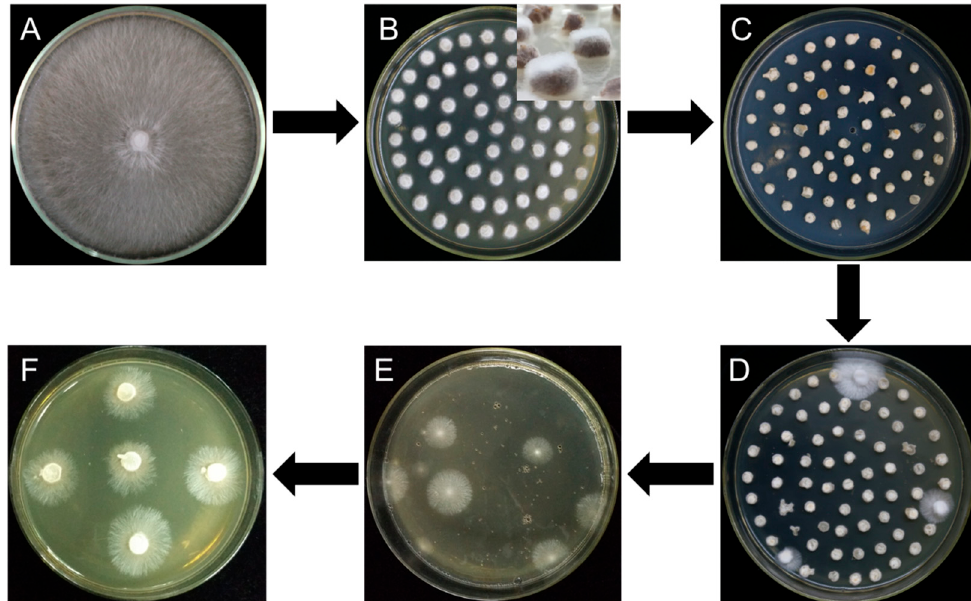
Figure 2. Flow diagram for Agrobacterium tumefaciens -mediated transformation of L. edodes. (A) Strain activation; (B) mycelial plugs overgrown with freshly germinated hyphae; (C) cocultivation; (D) first selection; (E) second selection; (F) third selection.